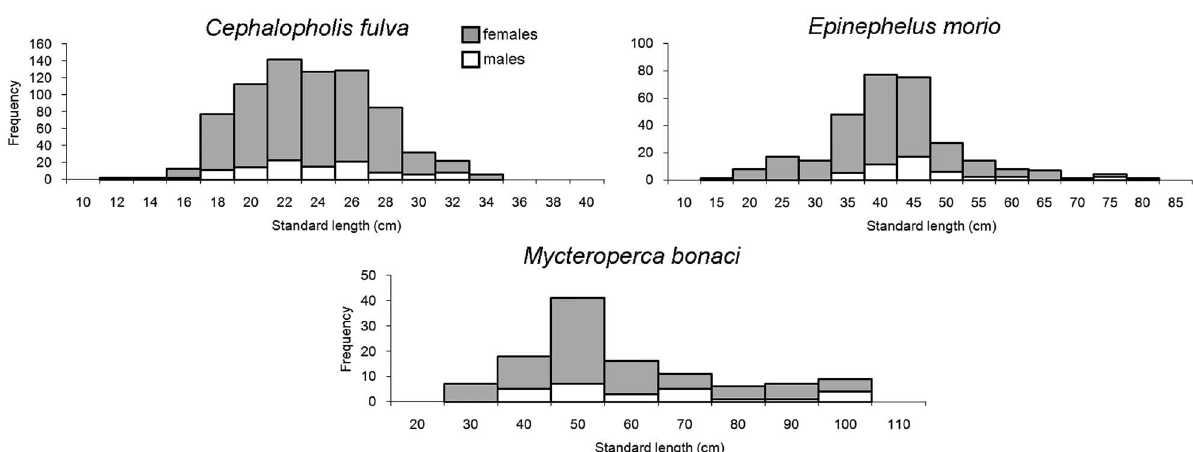
Fig . 3. – Proportion of males and females in different size categories for three commercially important reef fish species.